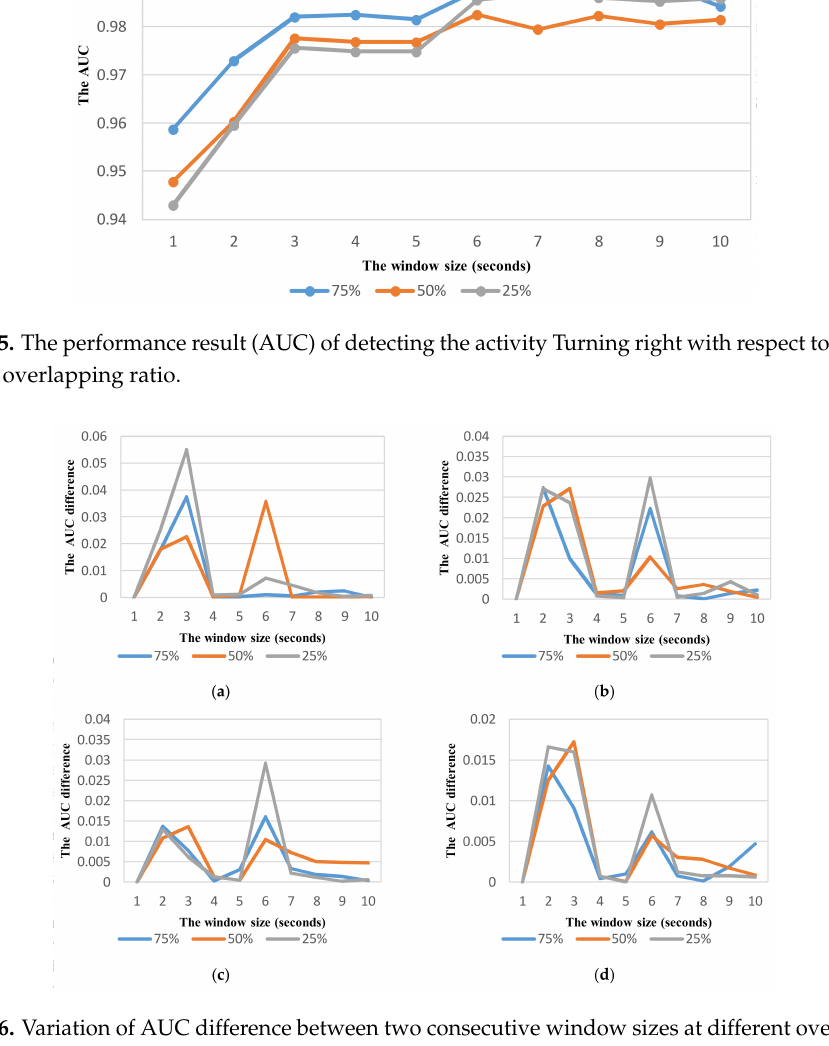
Figure 16. Variation of AUC difference between two consecutive window sizes at different overlapping ratios for activity mode detection: ( a ) Stop; ( b ) Going straight; ( c ) turning Left; ( d ) turning